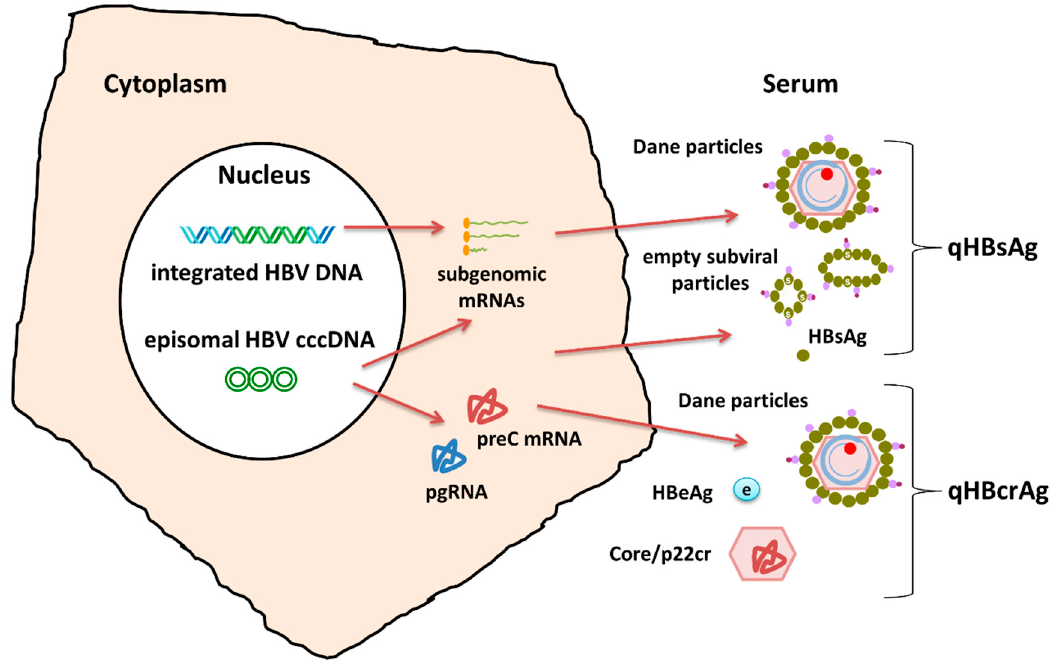
Figure 2. Serum HBsAg reflects the transcriptional activity of both cccDNA and integrated HBV sequences. preC mRNA: precore messenger RNA; pgRNA: pregenomic RNA; qHBcrAg: quantitative HBV core related antigen.